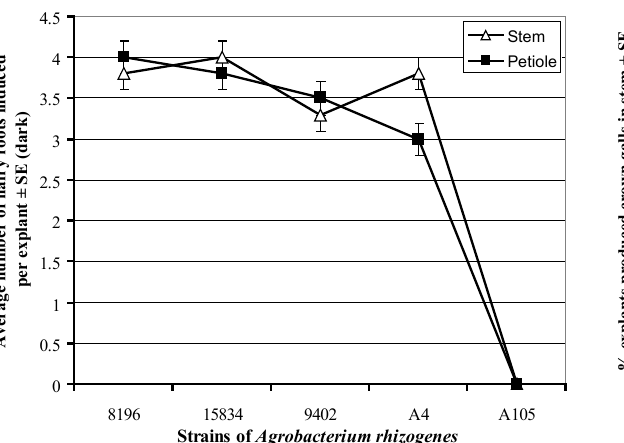
Fig. 7. Effect of acetosyringone on crown galls induction in peti- ole of muskmelon